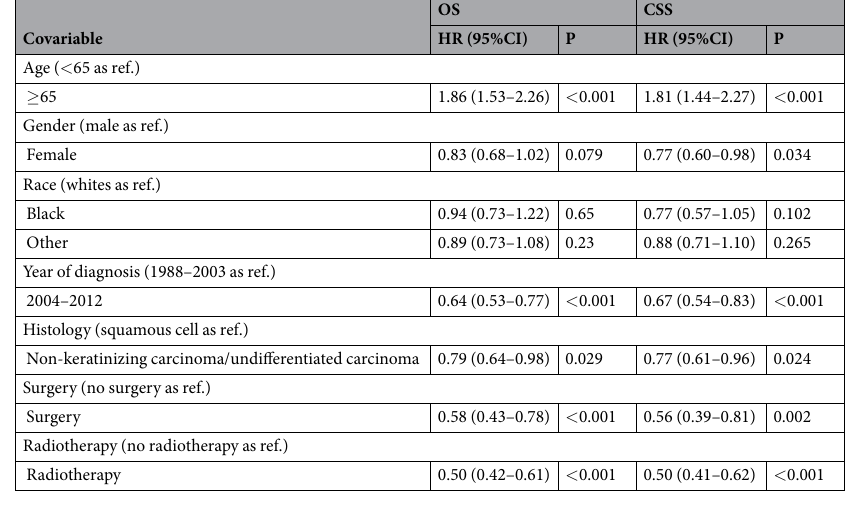
Table 3. Unweighted multivariate analyses of OS and CSS.